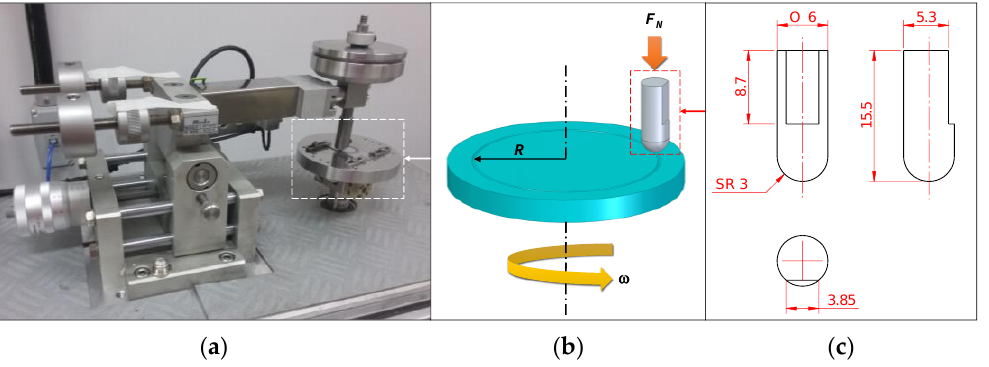
Figure 2. ( a ) Pin-on-disk tribometer; ( b ) motion diagram; ( c ) carbide pin dimensions (in mm). The operational parameters are listed in Table 3. The lubricant used in the tribological tests had a viscosity of 120 mPa and a density of 0.894 g/cm 3 . Table 3. Operating parameters used in the PoD test.